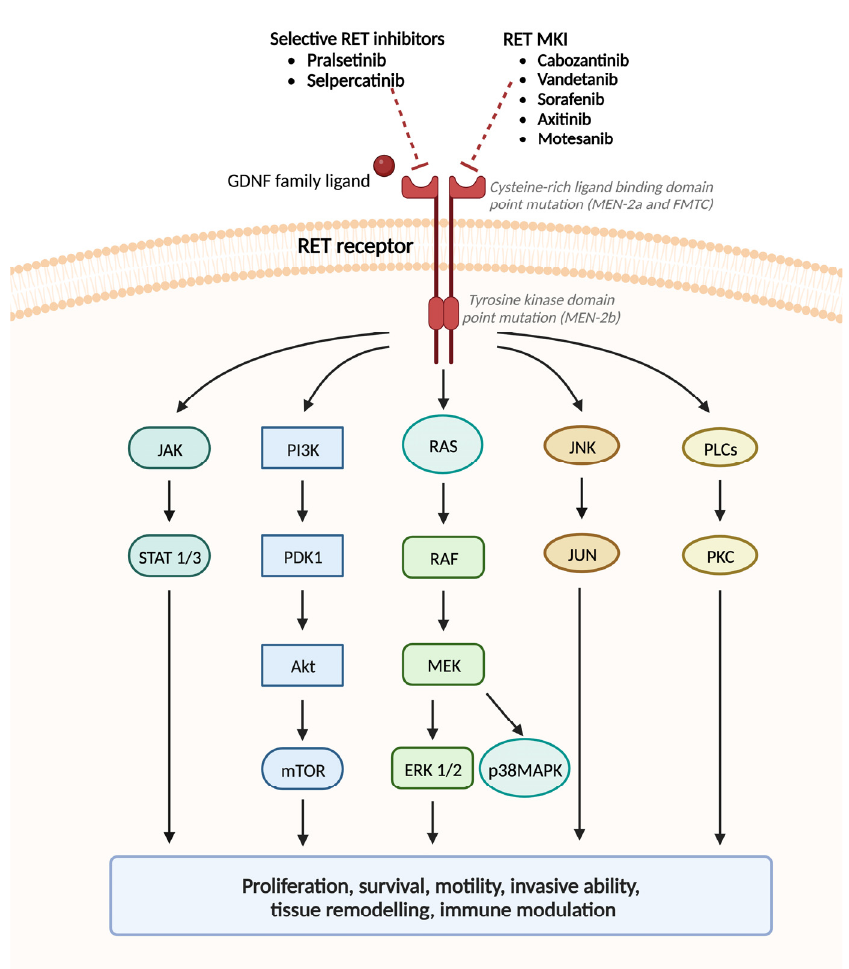
Figure 4. Overview of RET signaling pathways and their therapeutic targets. The RET TKR is composed of three functional domains:) the cysteine-rich extracellular ligand binding domain, the transmembrane domain, and two intracellular tyrosine kinase domains. After ligand binding, RET dimerizes and begins the protein kinase transcellular activation, leading to the autophosphorylation of various intracellular tyrosine residues. RET activates numerous signaling pathways involved in cells’ proliferation, apoptosis, motility, and immune modulation. The aberrant constitutive RET activation in MEN2 syndromes is caused by germline missense RET PV in the cysteine residues in the extracellular cysteine-rich domain or in the intracytosolic tyrosine kinase domain, associated with MEN2A and MEN2B, respectively. Several drugs studied can block RET signalling upstream of the pathway: MKI inhibit RET and other TKR receptors; newer inhibitors, on the other hand, are more selective and only inhibit RET.